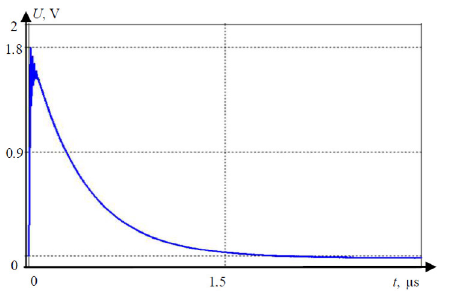
Figure 15. Electromagnetic disturbance example in the coupling